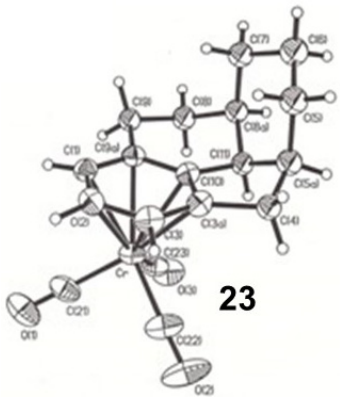
Figure 5. Molecular structure of ( η 6 -octahydro-cpp)Cr(CO) 3 , 23 .